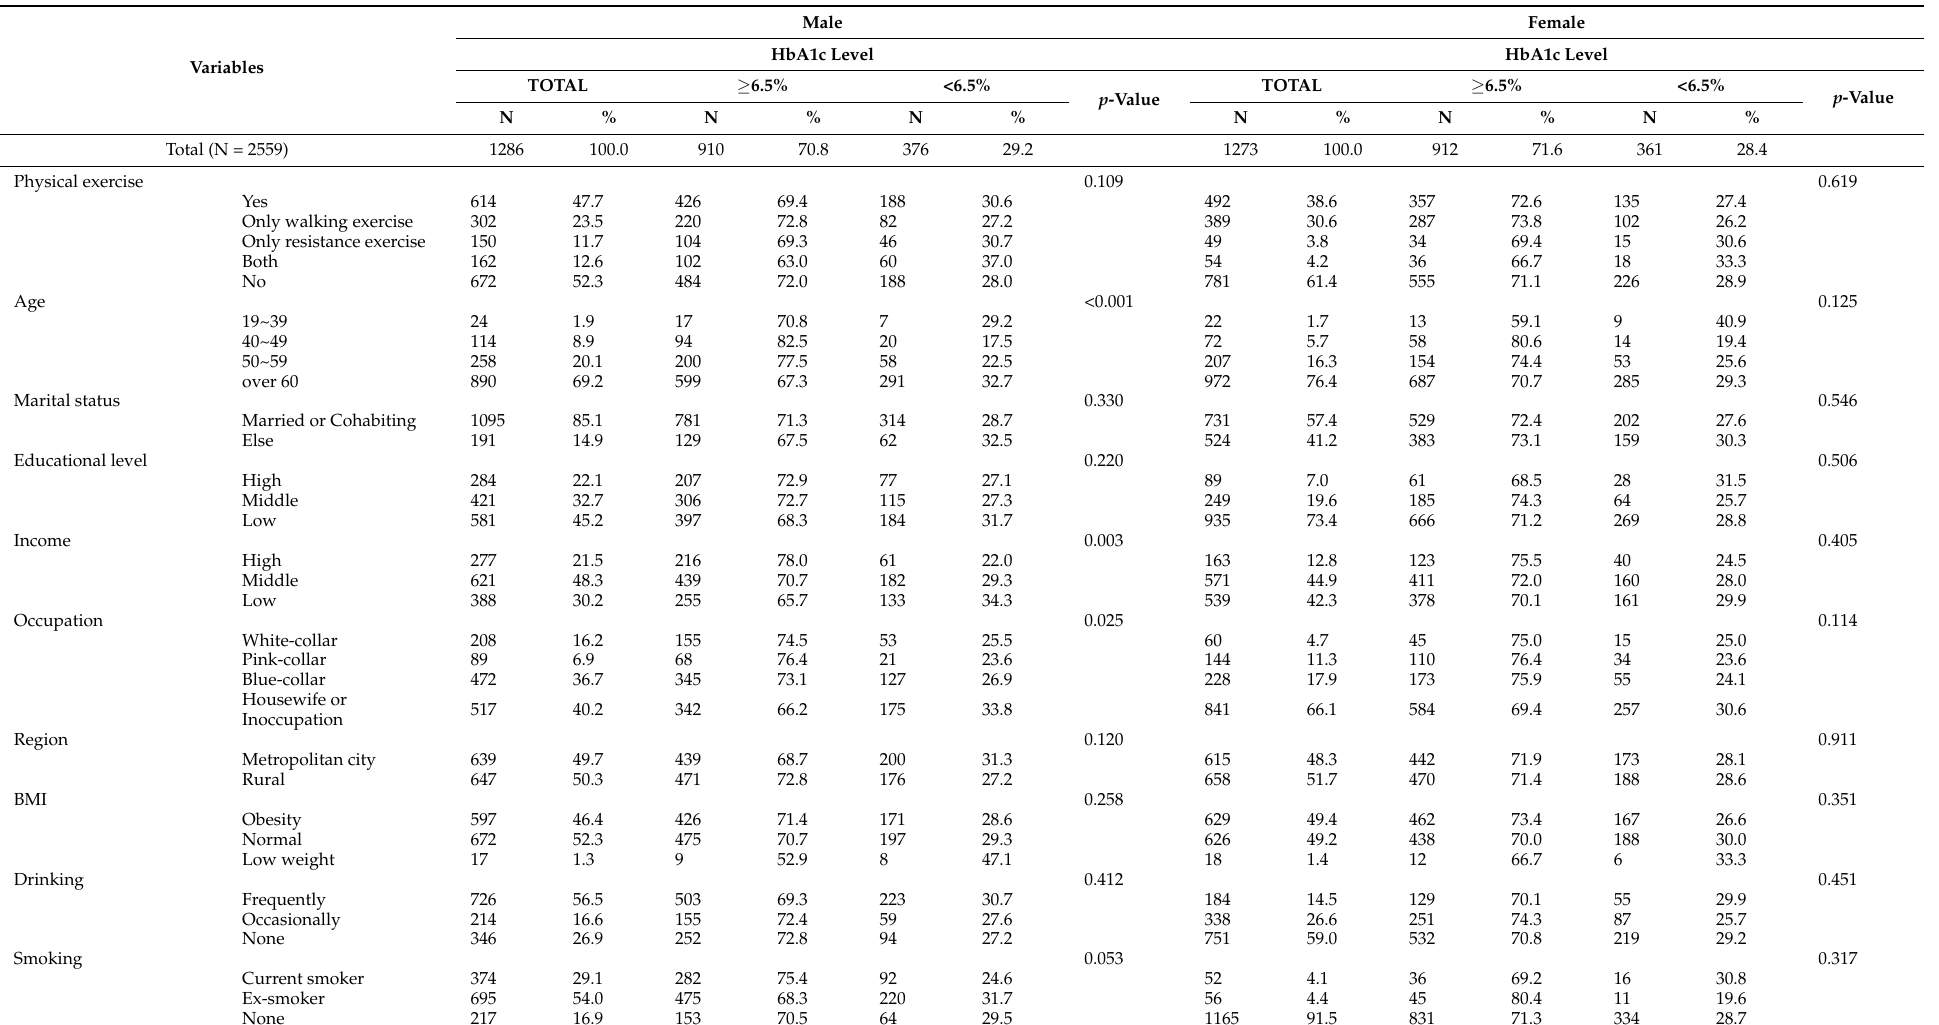
Table 1. General characteristics of the study